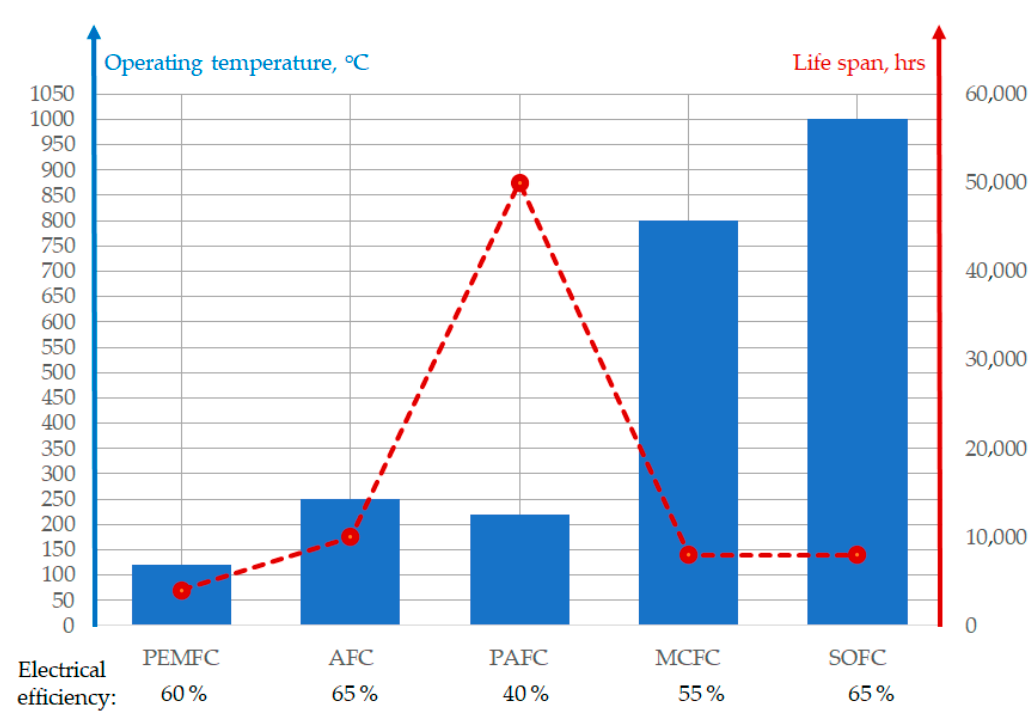
Figure 3. Comparative characteristics of fuel cells of various types.